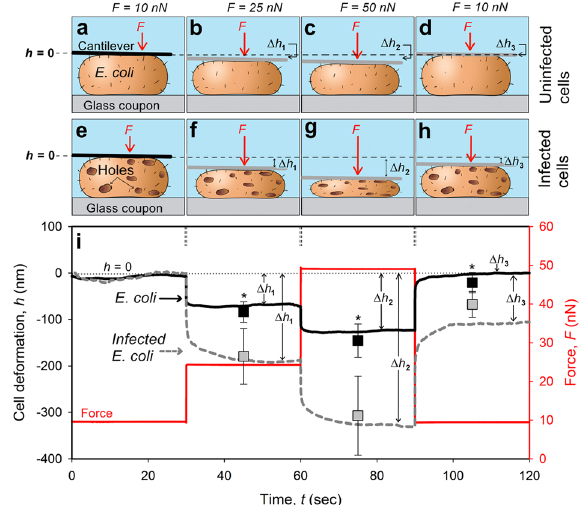
Fig. 5 AFM measurements of applied force, F , and cell deforma- tion, h , vs. time of applied force for infected and uninfected (carried out in separate experiments with no addition of T4 phages) E. coli cells. Two hours after the addition of T4 phages, infected E. coli were identi fi ed and analyzed according to the red fl uorescence (i.e., “ dead ” ) of cells with de fi ned structure. a – d Schematic illustration of the tipless cantilever as it deforms the uninfected and e – h infected E. coli cells at different applied forces. Black full lines a , e indicate the initial position of the tipless AFM cantilever, while the gray lines b – d , f – h mark the position of that cantilever following the application of a speci fi c force. i A representative curve where the deformation (indentation), h , was set to zero when the AFM cantilever applied F = 10 nN. The deformations of uninfected or infected E. coli cells ( Δ h 1 , Δ h 2 , and Δ h 3 ) were measured by applying 25 nN, 50 nN, and 10 nN, respectively. Scatterplot indicates the average and s.d. from 12 different bacteria measured at 3 – 5 independent experiments. Asterisks indicate a statistically signi fi cant difference between uninfected and infected E. coli cells ( p < 0.01, n =